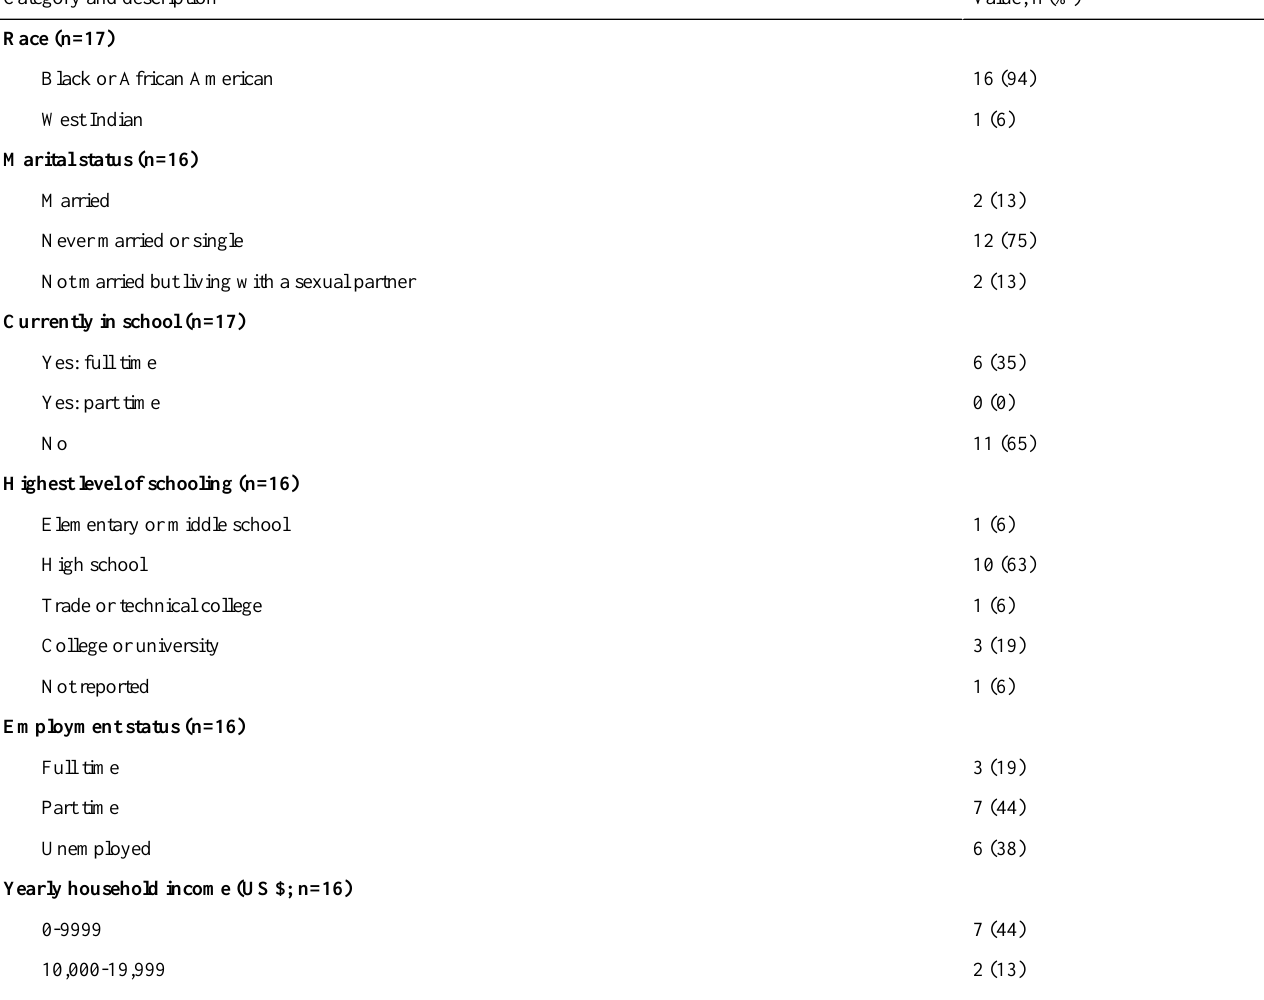
Table 1. Participant